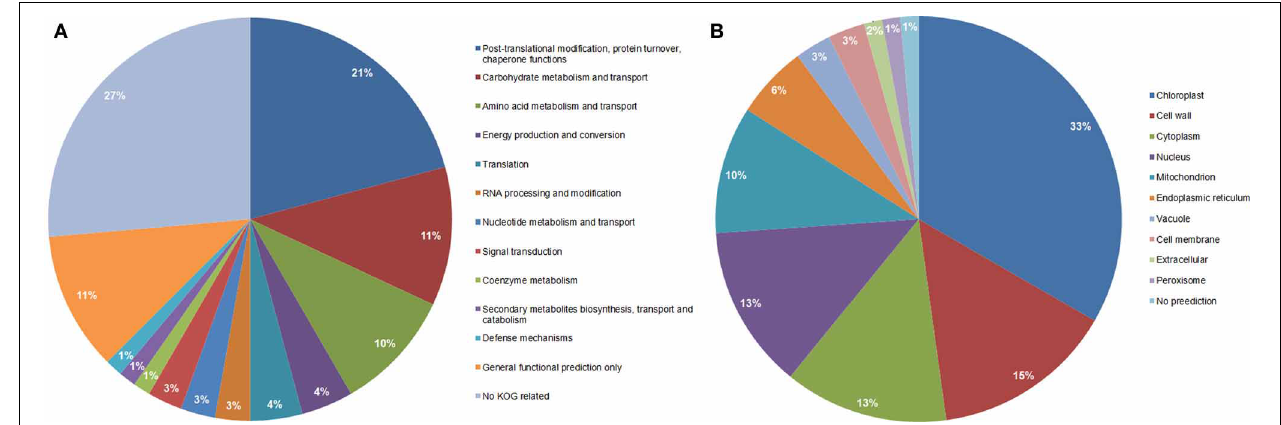
FIGURE 3 | Functional classification (A), and subcellular localization prediction (B), of the 69 proteins identified by LC-MS/MS in total protein